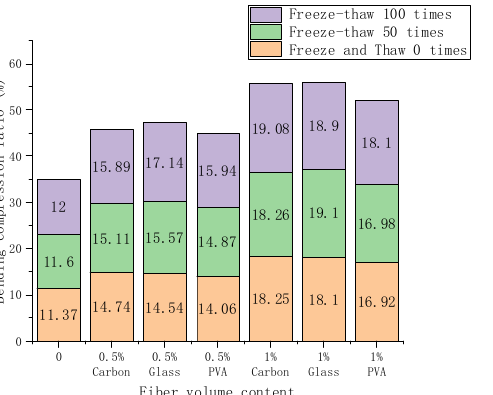
Figure 9. Variation of bending-compression ratio with doping and freeze-thaw time. Table 7. The bending-compressive ratio.